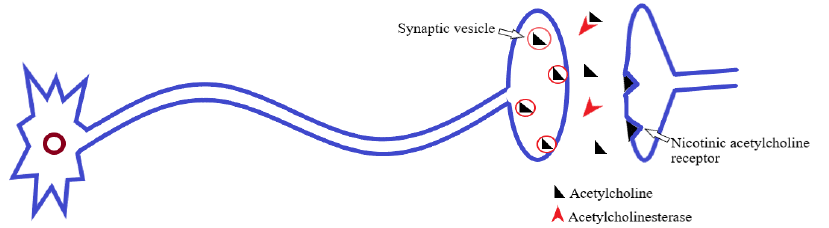
Figure 2. Acetylcholine release, postsynaptic receptor binding, and hydrolysis by acetylcholinester- ase